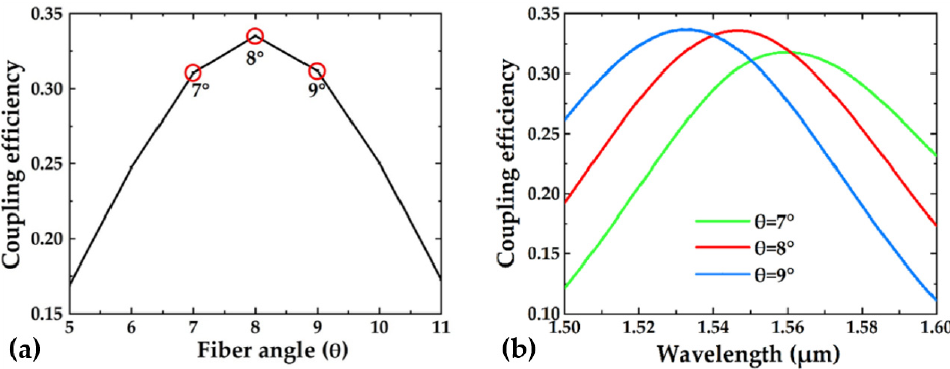
Figure 6. ( a ) Coupling efficiency as a function of Lx . ( b ) Coupling efficiency as a function of Ly .